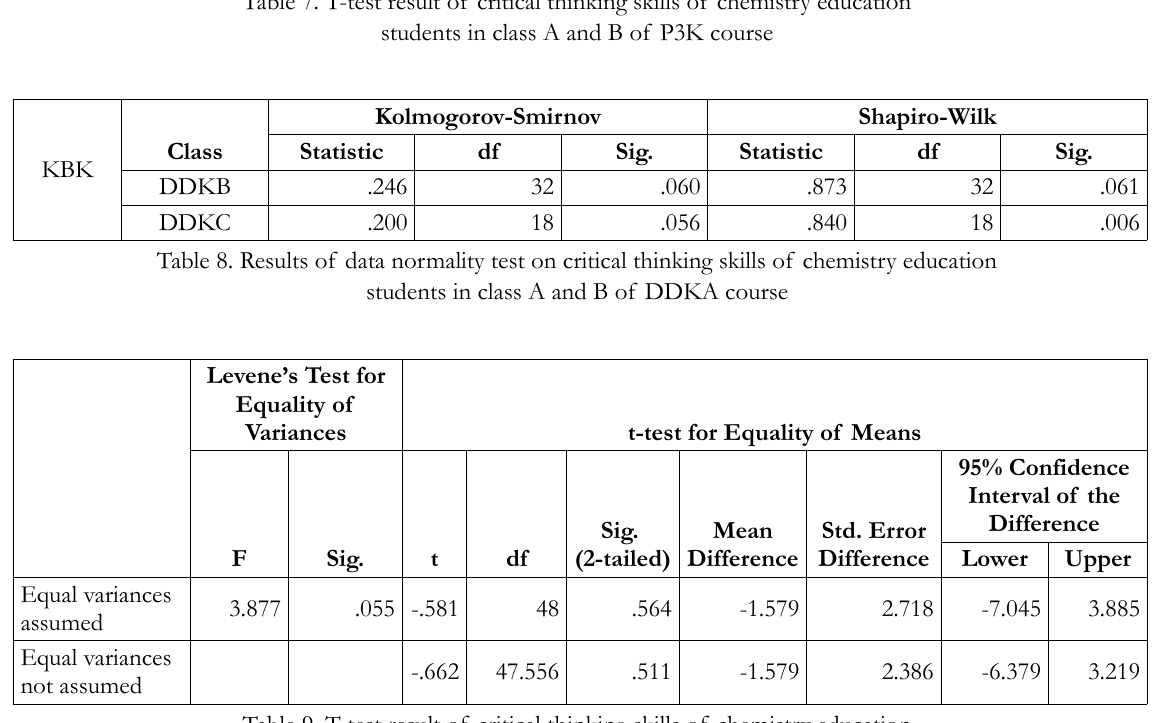
Table 9. T-test result of critical thinking skills of chemistry education students in class A and B of DDKA